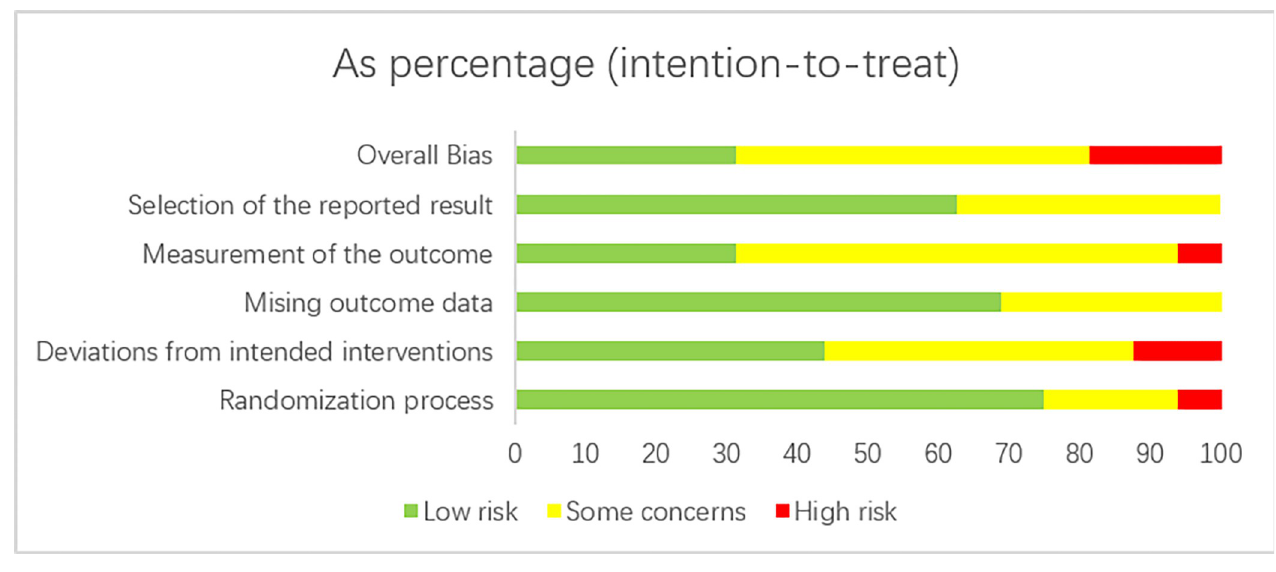
Fig 2. Risk of bias in the